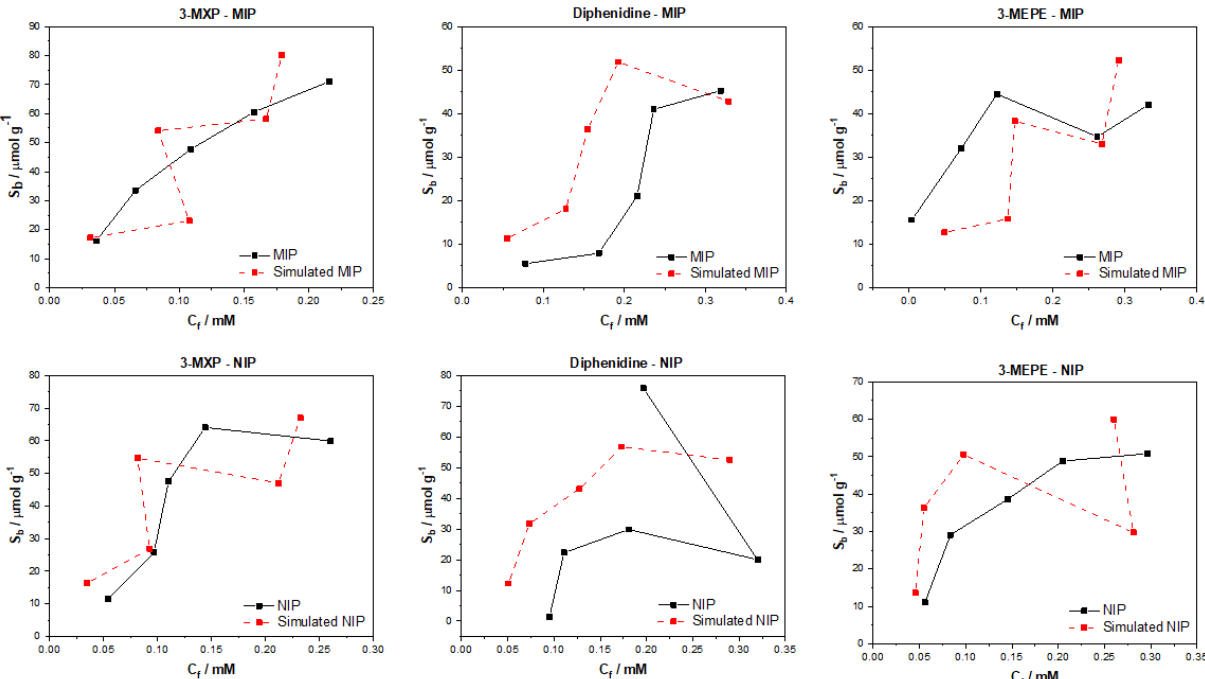
Figure 8. Graph convolution with a weave featurizer simulated and experimental binding isotherms for MIP and NIP in regard to the binding of 3-MXP, diphenidine, and 3-MEPE.